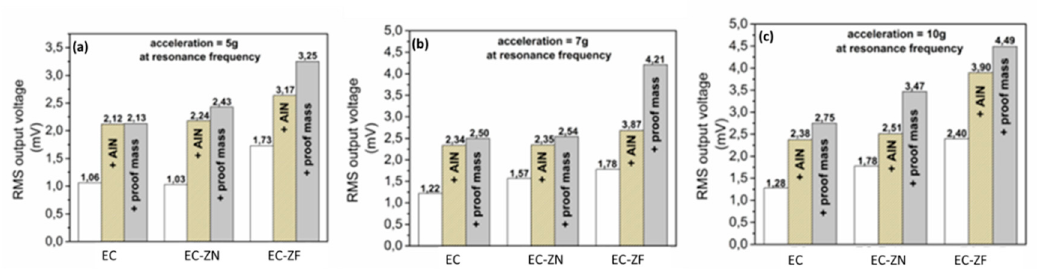
Figure 1. Root Mean Square output voltage values obtained by the different fabricated beams configurations at their resonance frequency for three acceleration values: ( a ) 5 g, ( b ) 7 g and ( c ) 10